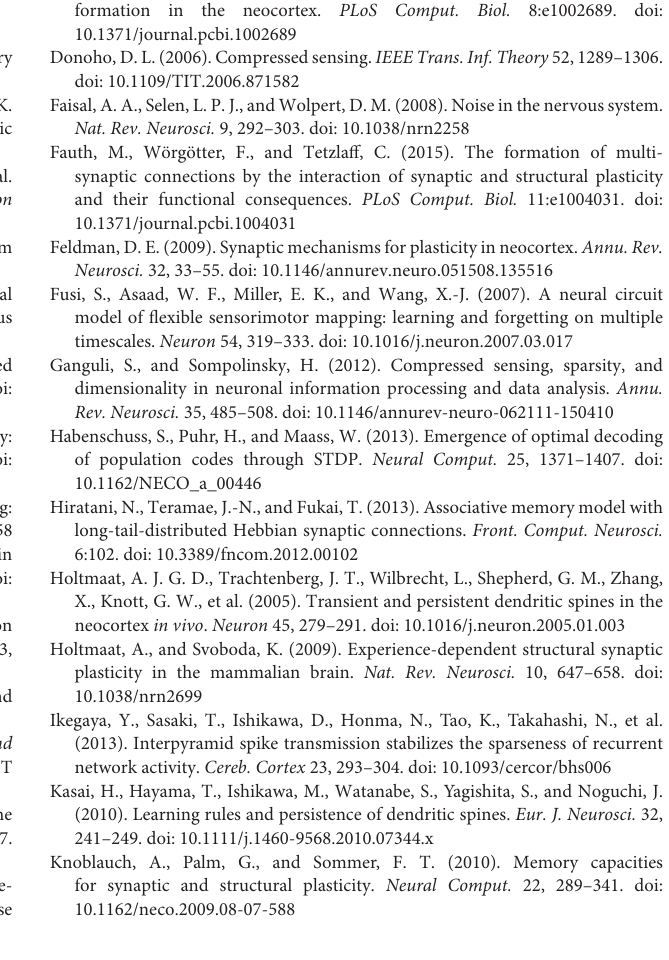
Supplementary Figure 1 | Results in Poisson model. (A) An example of output neuron activity before (top) and after (bottom) synaptic weight learning at connectivity ρ 0.25. (B) Synaptic weight matrices before (left) and after (right) = learning. Both X-neurons and Y-neurons were sorted based on their preferred external states. (C) Accuracy of estimation at various timescale of rewiring τ c . (D) Model error calculated from connectivity (left) and synaptic weights (right). (E) Comparison of performance among the model without wiring plasticity (cyan), and dual Hebbian model(orange). Corresponding results in the Gaussian model are described in Figures 4A , 5F,G , 6E,F,I ,